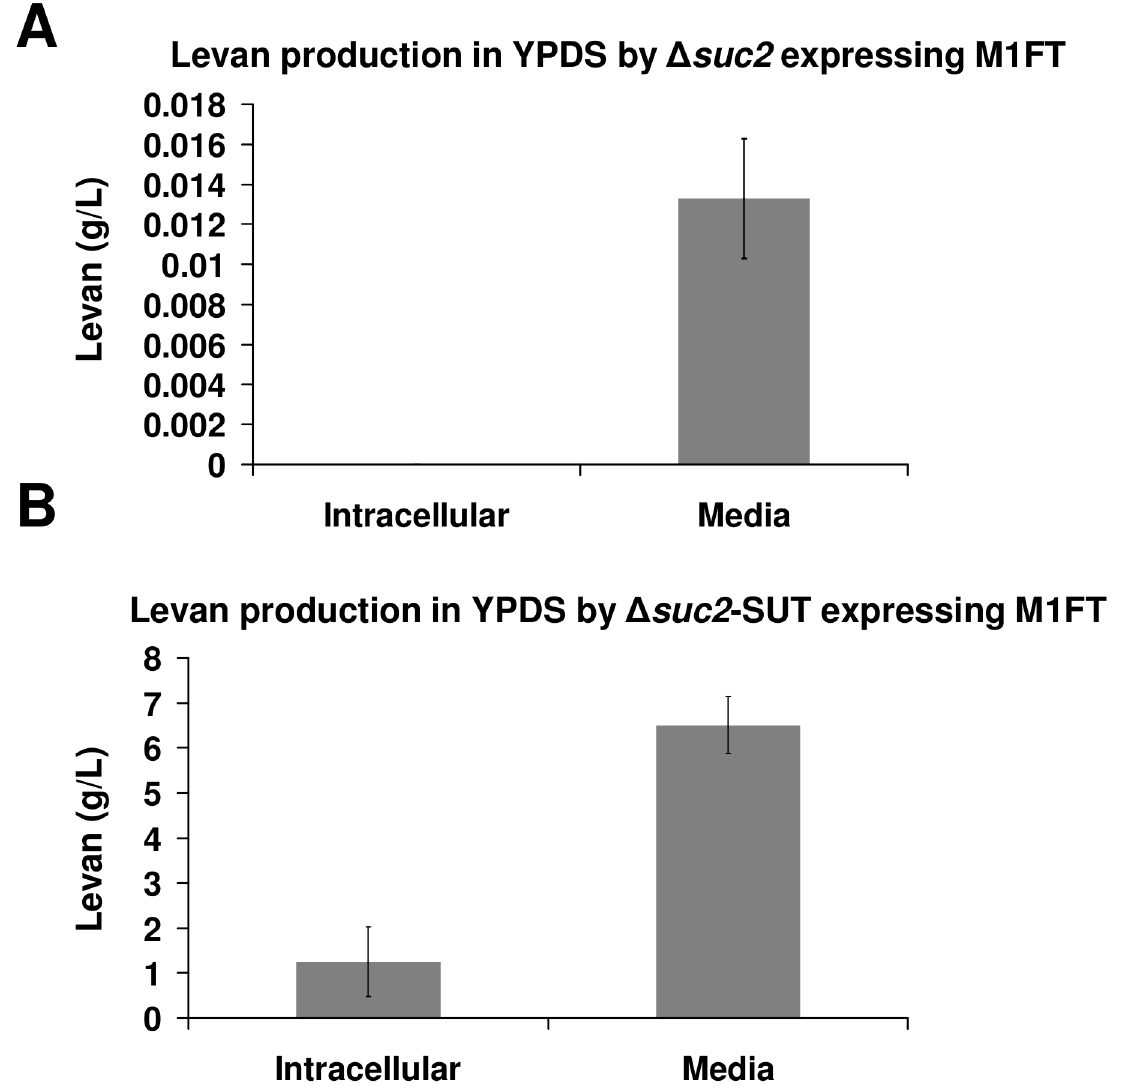
Figure 5. Quantification of levan production by M1FT transformed strains in rich media supplemented with sucrose (YPDS). Quantification was done by densitometric analysis of the urea stained levan polymers after visualization on TLC plates. Produced levan was either quantified from cell extracts (Intracellular) or from the growth medium (Media). Error bars indicate standard deviation (in g/L) within a triplicate sample set. (A) Levan produced by M1FT expressed in the BY4742Δ suc2 genetic background. (B) Levan production by M1FT expressed in the BY4742Δ suc2 -SUT genetic background.